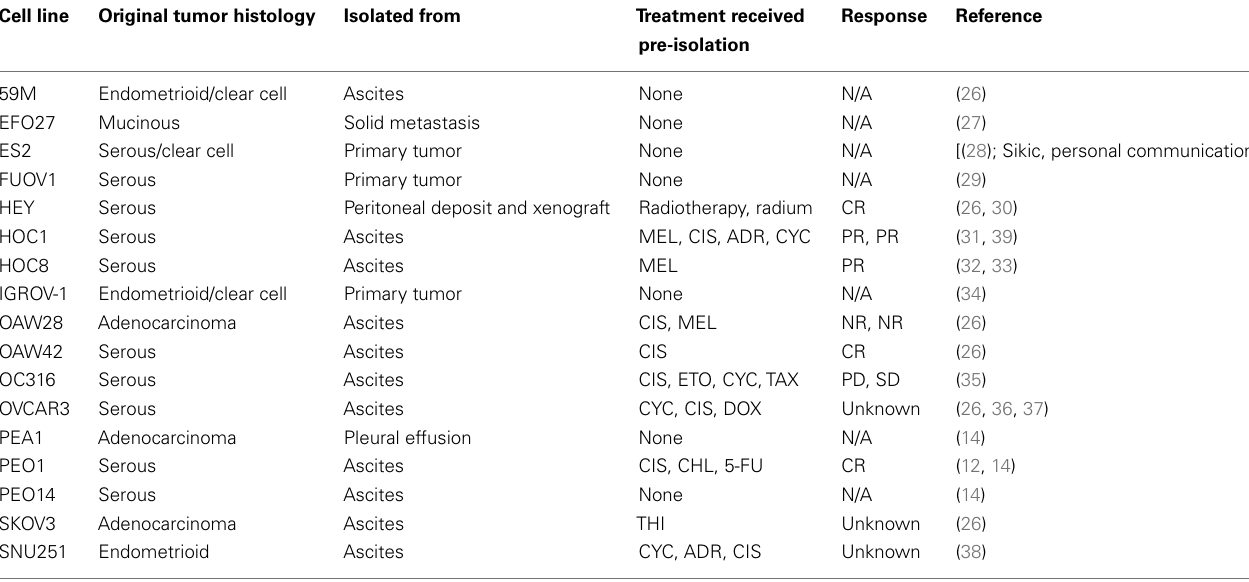
Table 3 | Clinical characteristics of ovarian tumors from which ovarian cell lines were established . Cell